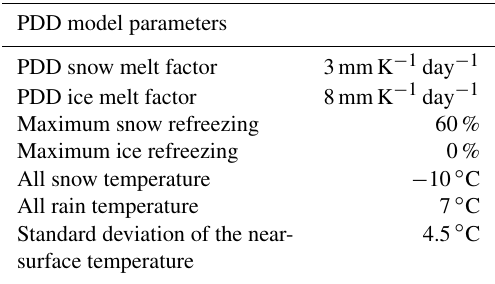
Table 1. Model parameters of the empirical PDD model. Table 2. Model parameters of the intermediate complexity BESSI